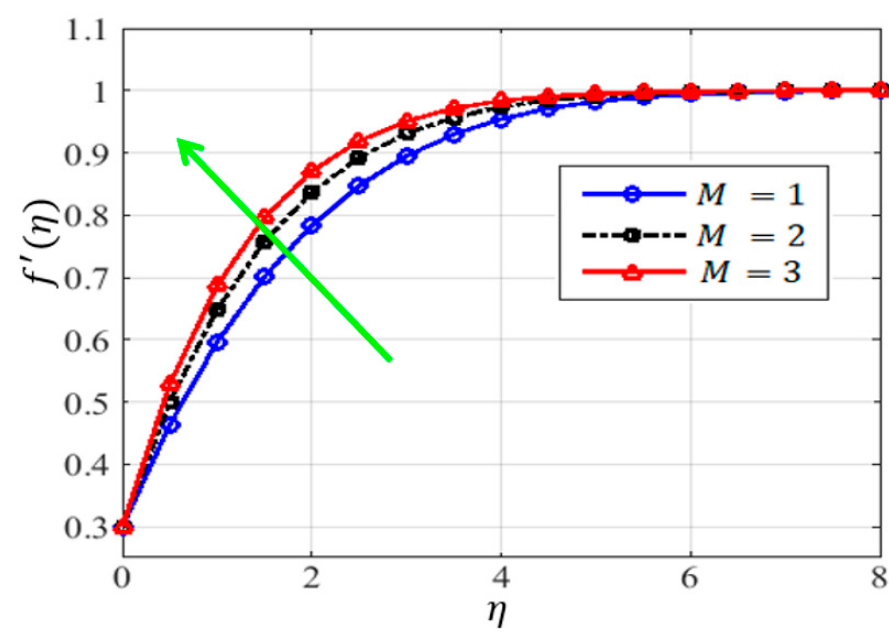
Figure 6. Impact of magnetic field parameter on velocity profile.